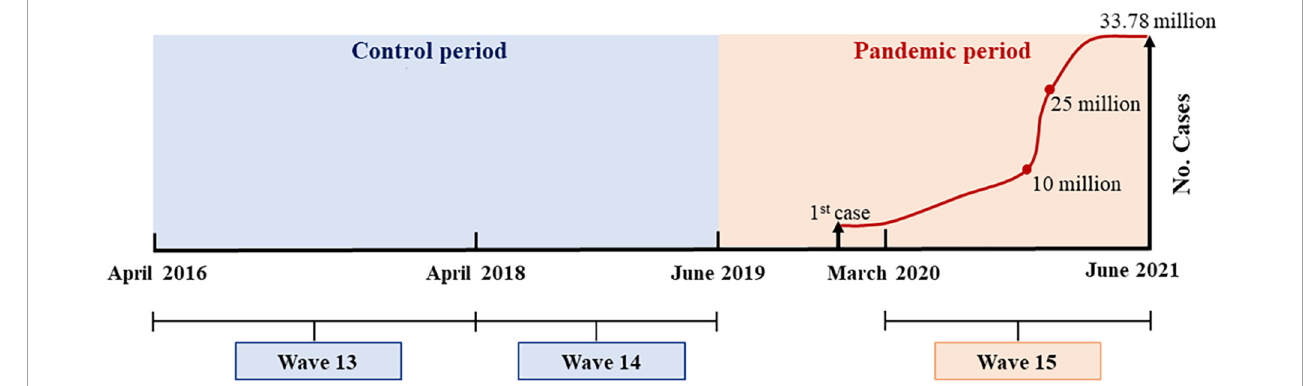
FIGURE1 Timeline of Health and Retirement Study (HRS) surveys and cumulative-confirmed coronavirus disease 2019 (COVID-19) cases in the United States.